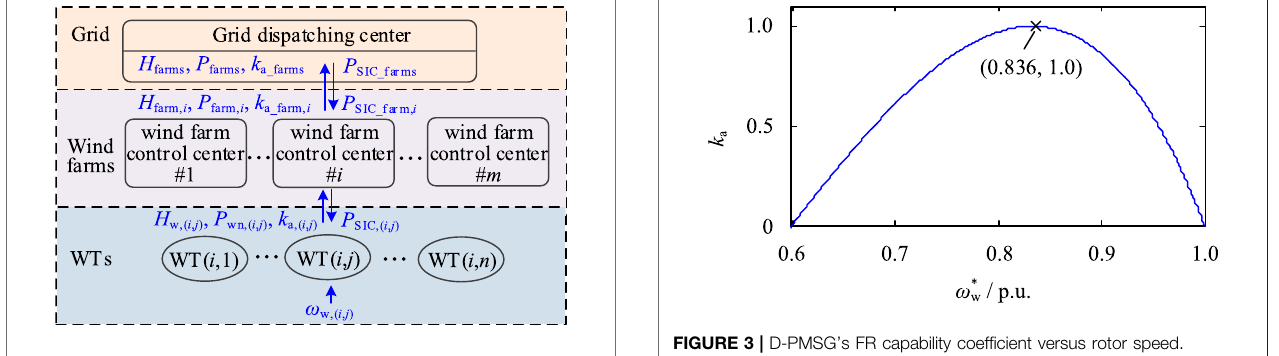
FIGURE 2 | Structure of cooperative synthetic inertia control for wind farms.